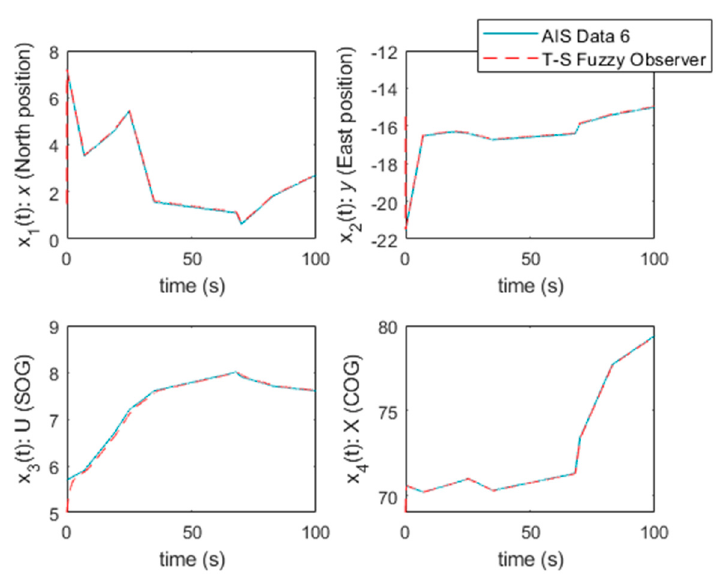
Figure 14. Simulation results of AIS data 5.